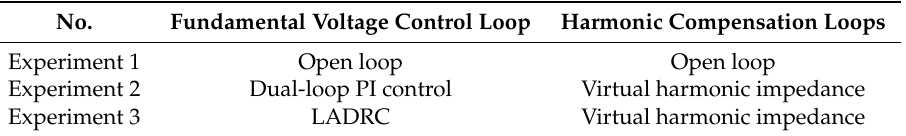
Table 6. The Design of Experiments.